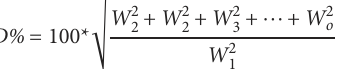
FIGURE 7 Time domain parameter